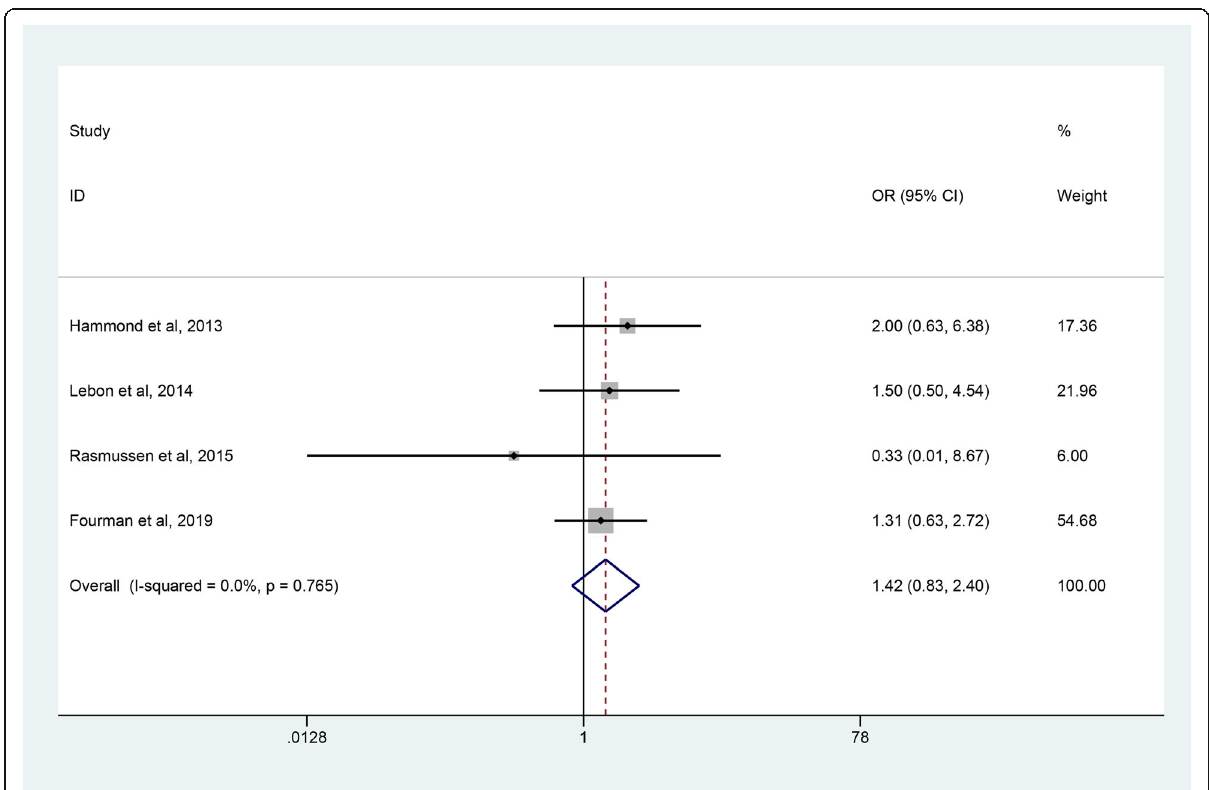
Fig. 10 Forest plot comparing complication rates after resurfacing hemiarthroplasty (RHA) versus stemmed hemiarthroplasty